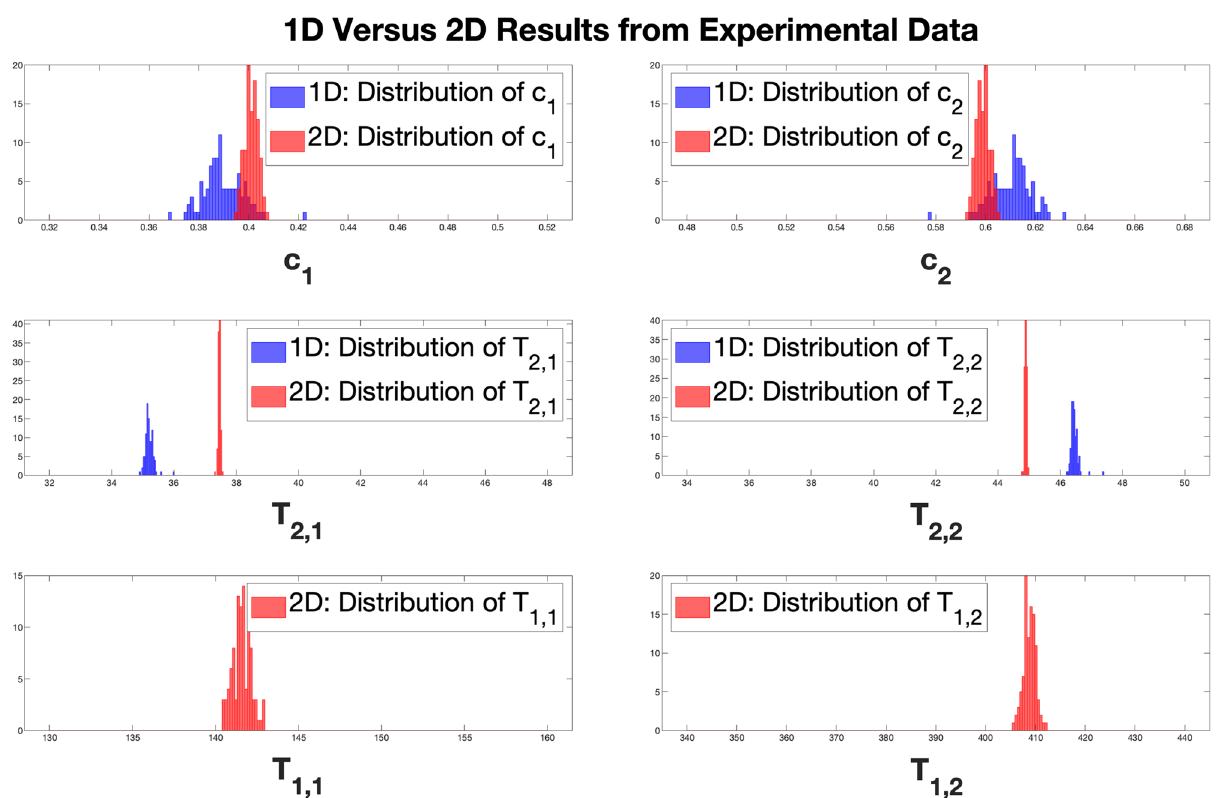
Figure 11. Histograms of the fitted values for the indicated parameters derived using NLLS from 100 sets of experimental data. The comparisons in the upper two rows are for 1D versus 2D. Note that the mirror image appearance of c 1 and c 2 arises from the constraint that c 1